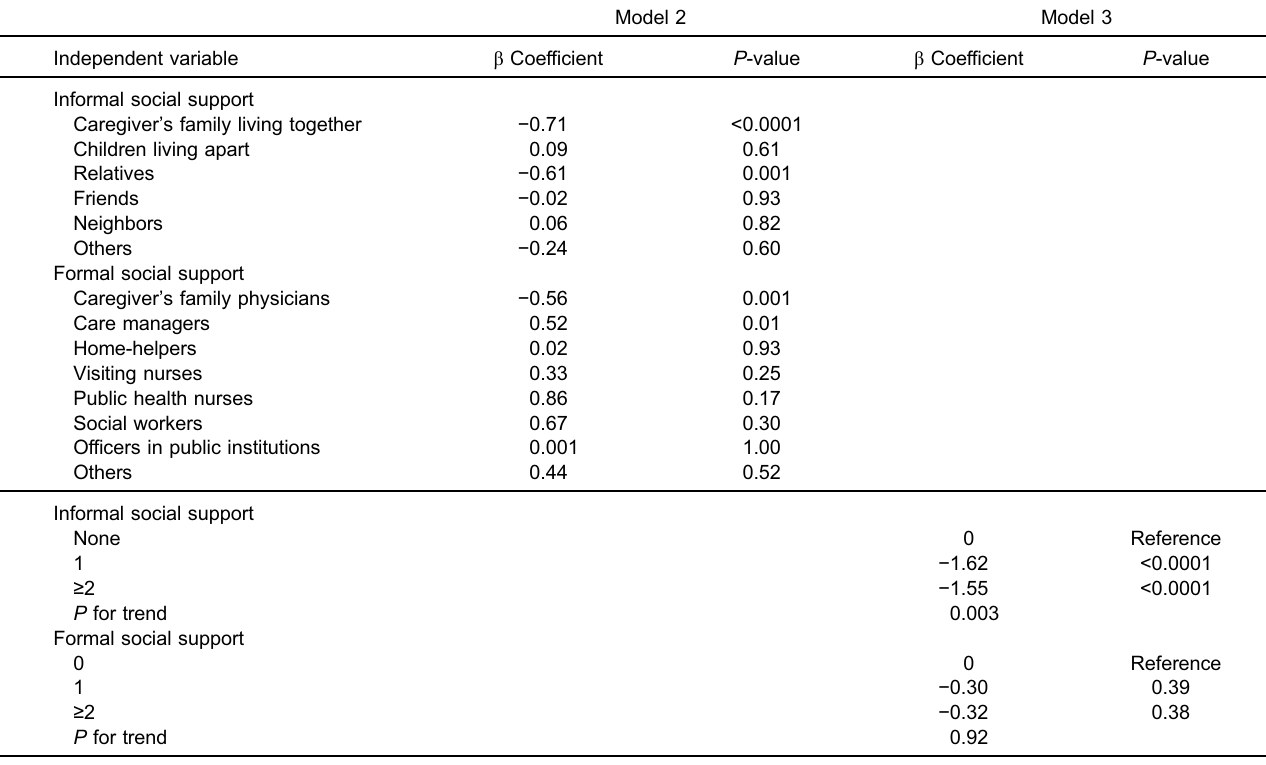
Table 3. Multiple linear regression model for caregiver ’ s burden score by speci fi c sources of informal and/or formal social support (Model 2) and by the number of informal and/or formal social supports (Model 3) ( n =